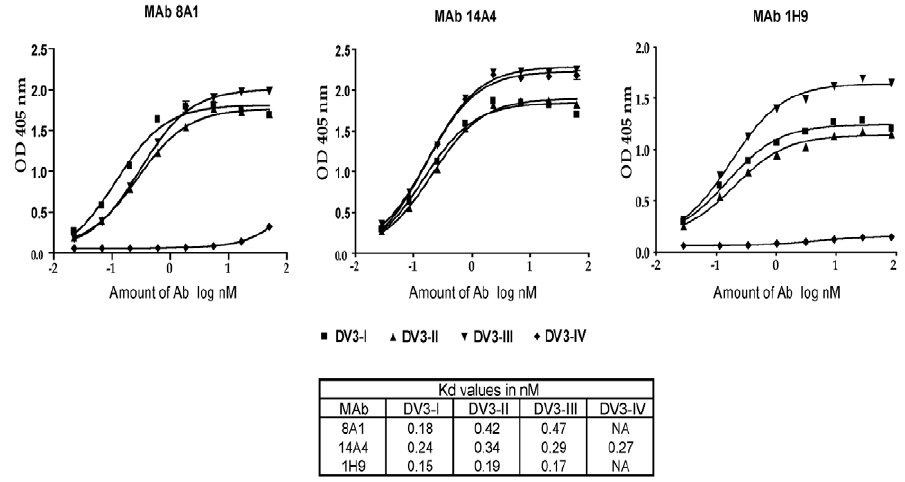
Figure 6. Binding of mouse MAbs to DENV3 genotypes. DENV3 genotype I (DV3-I), genotype II (DV3-II), genotype III (DV3-III) and genotype IV (DV3-IV) viruses were purified and used in binding assays with MAb 8A1, 14A4 and 1H9. MAb 14A4 bound to all 4 genotypes with similar apparent affinity. MAbs 8A1 and 1H9 bound to DENV3, genotypes I, II and III with similar apparent affinity, while no binding was detected with genotype IV